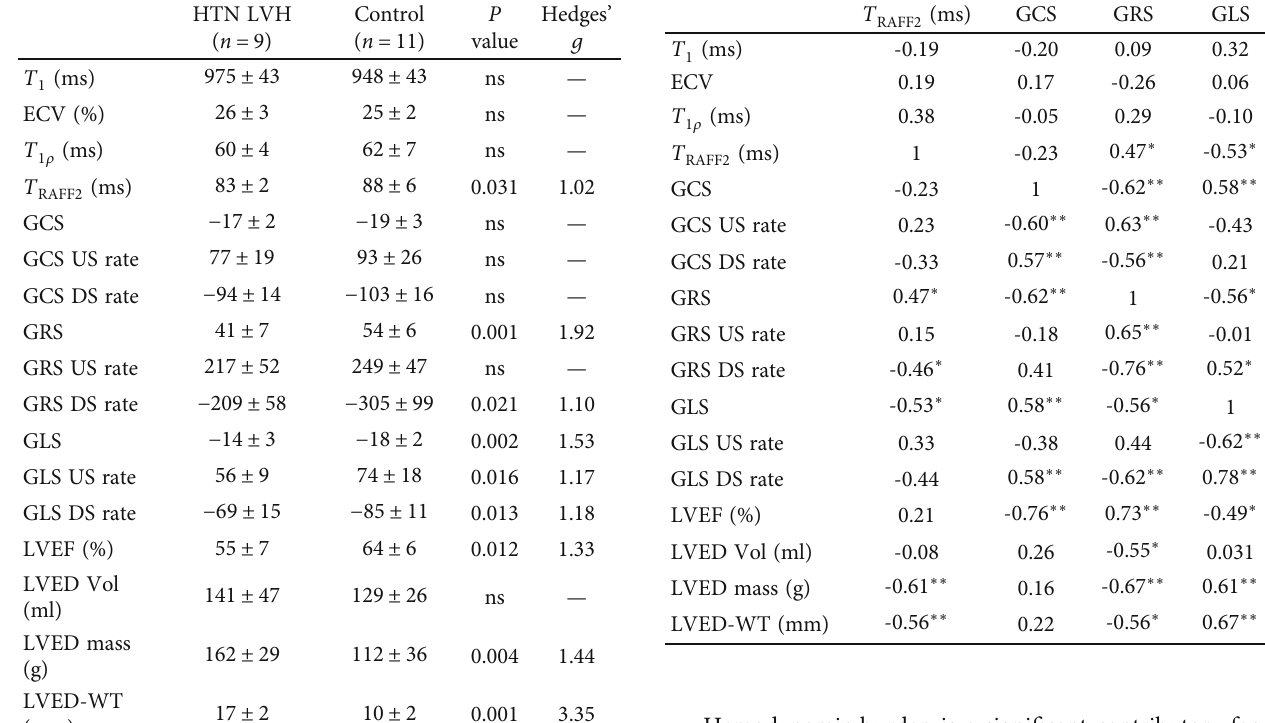
Table 2: Pearson correlation coe ffi cients ( r ) between T